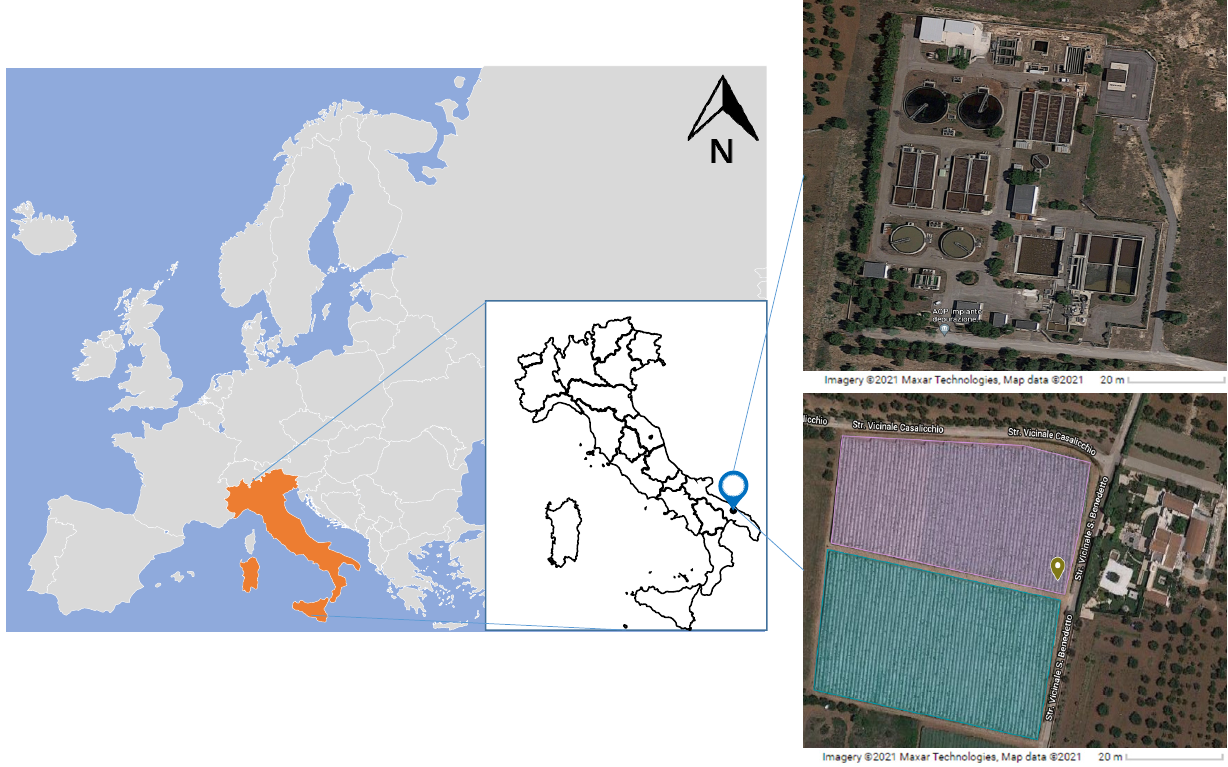
Figure 1. Location of the study area in the municipality Acquaviva delle Fonti (Apulia region), wastewater treatment plant (upper photo), and experimental site (lower